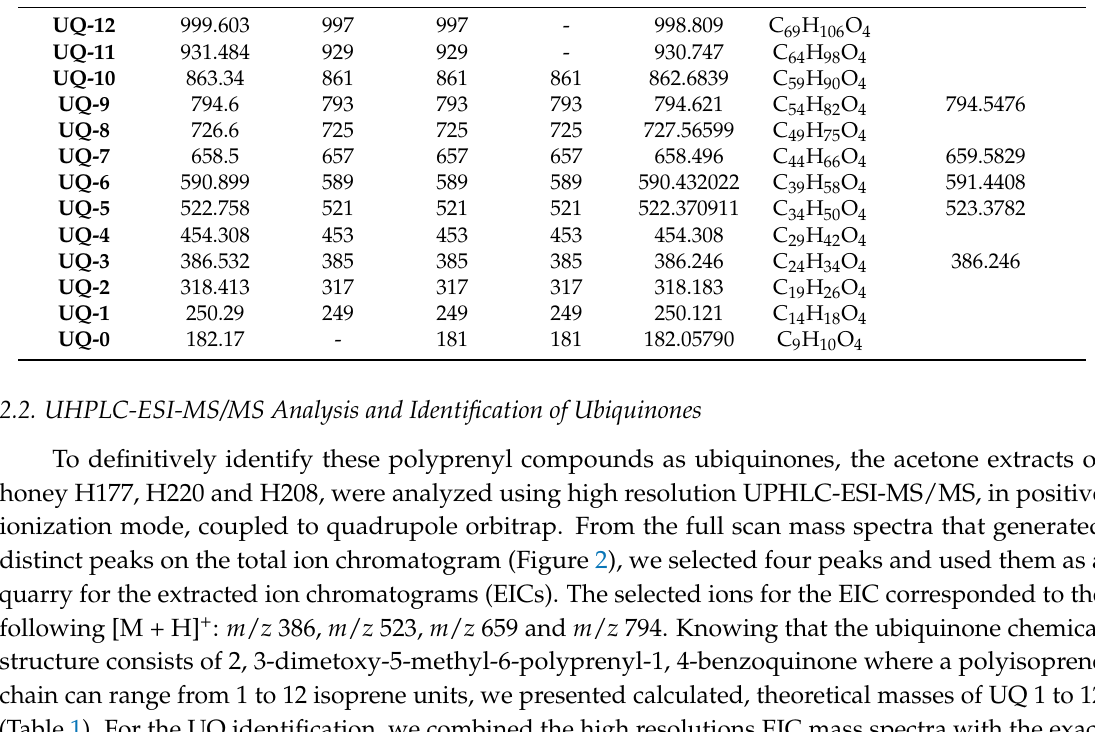
Table 1. Major mass ions of ubiquinones detected during solvent extraction of honey. Compound Mol.